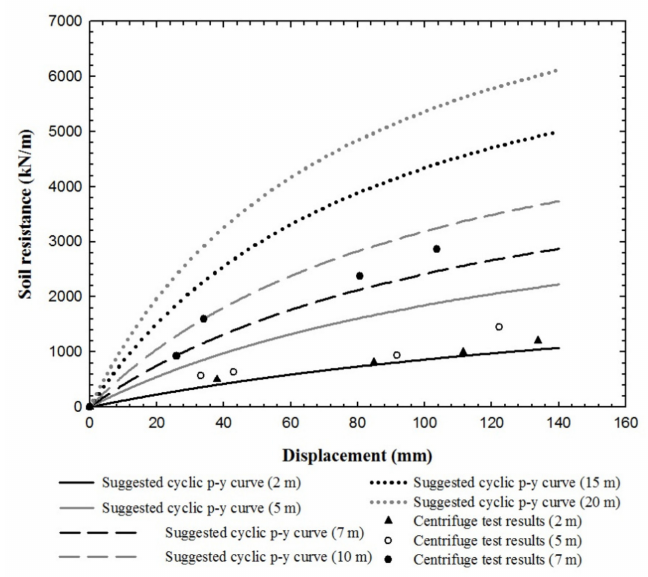
Figure 16. Suggested cyclic p-y curve using the first cycle.